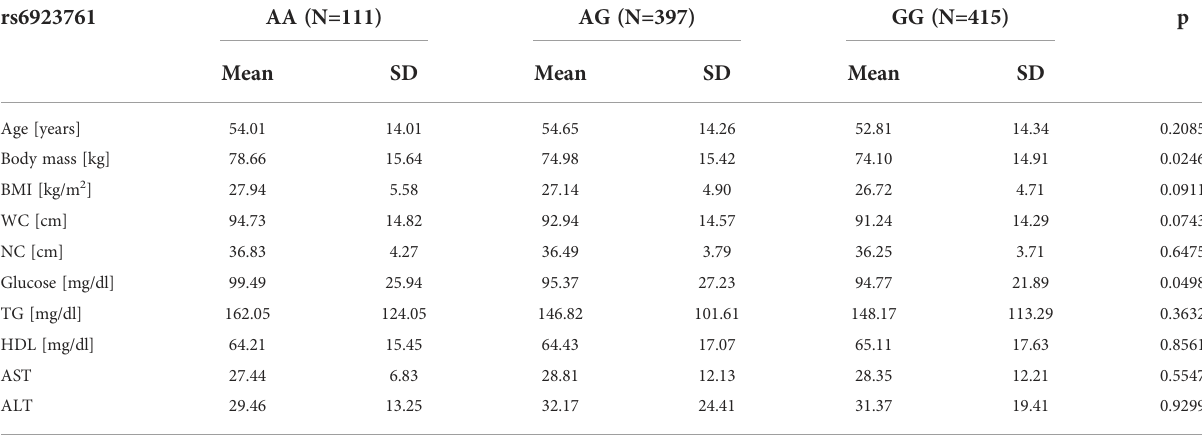
TABLE 5 Comparison of anthropometric measurements and selected metabolic parameters between particular genotypes of rs6923761 variant.